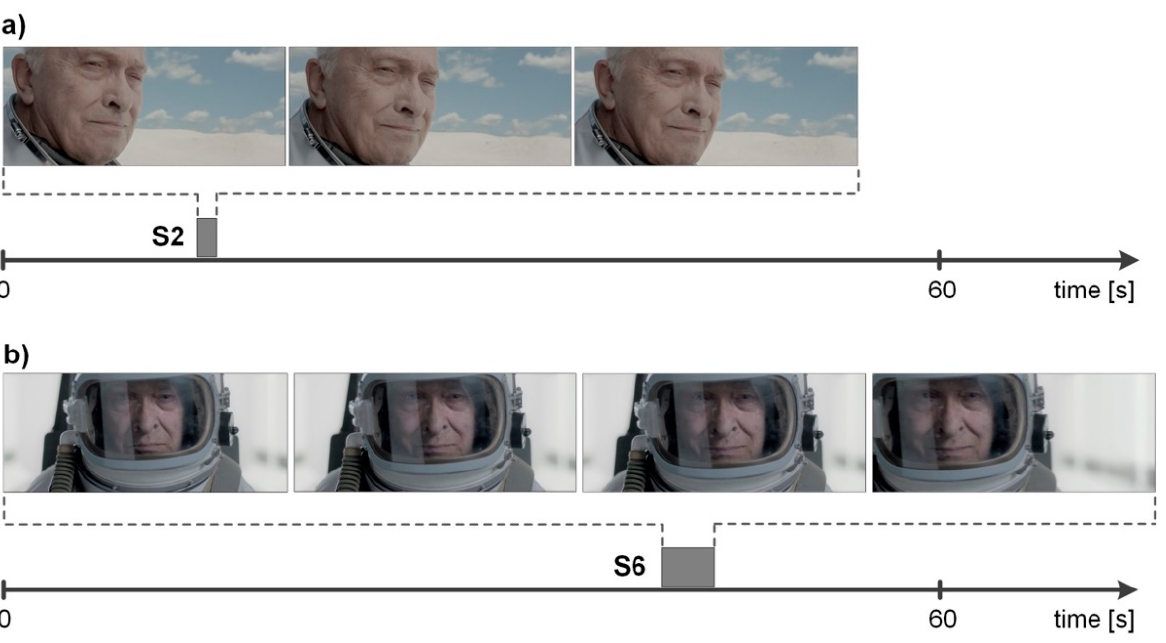
Figure 4. Frames extracted from advertisement under study: ( a ) for S2; ( b ) for S6.